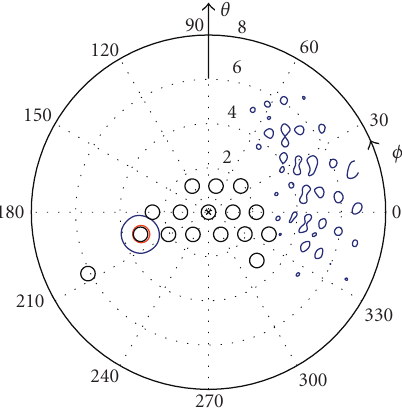
Figure 8: Array pattern for the configuration depicted in Figure 6. The beam is pointing at Europe edges. The red line represents the iso-level curves at 43.8 dBi, and the blue ones the iso-level curves at 20dBi. The black circles represent the interfering